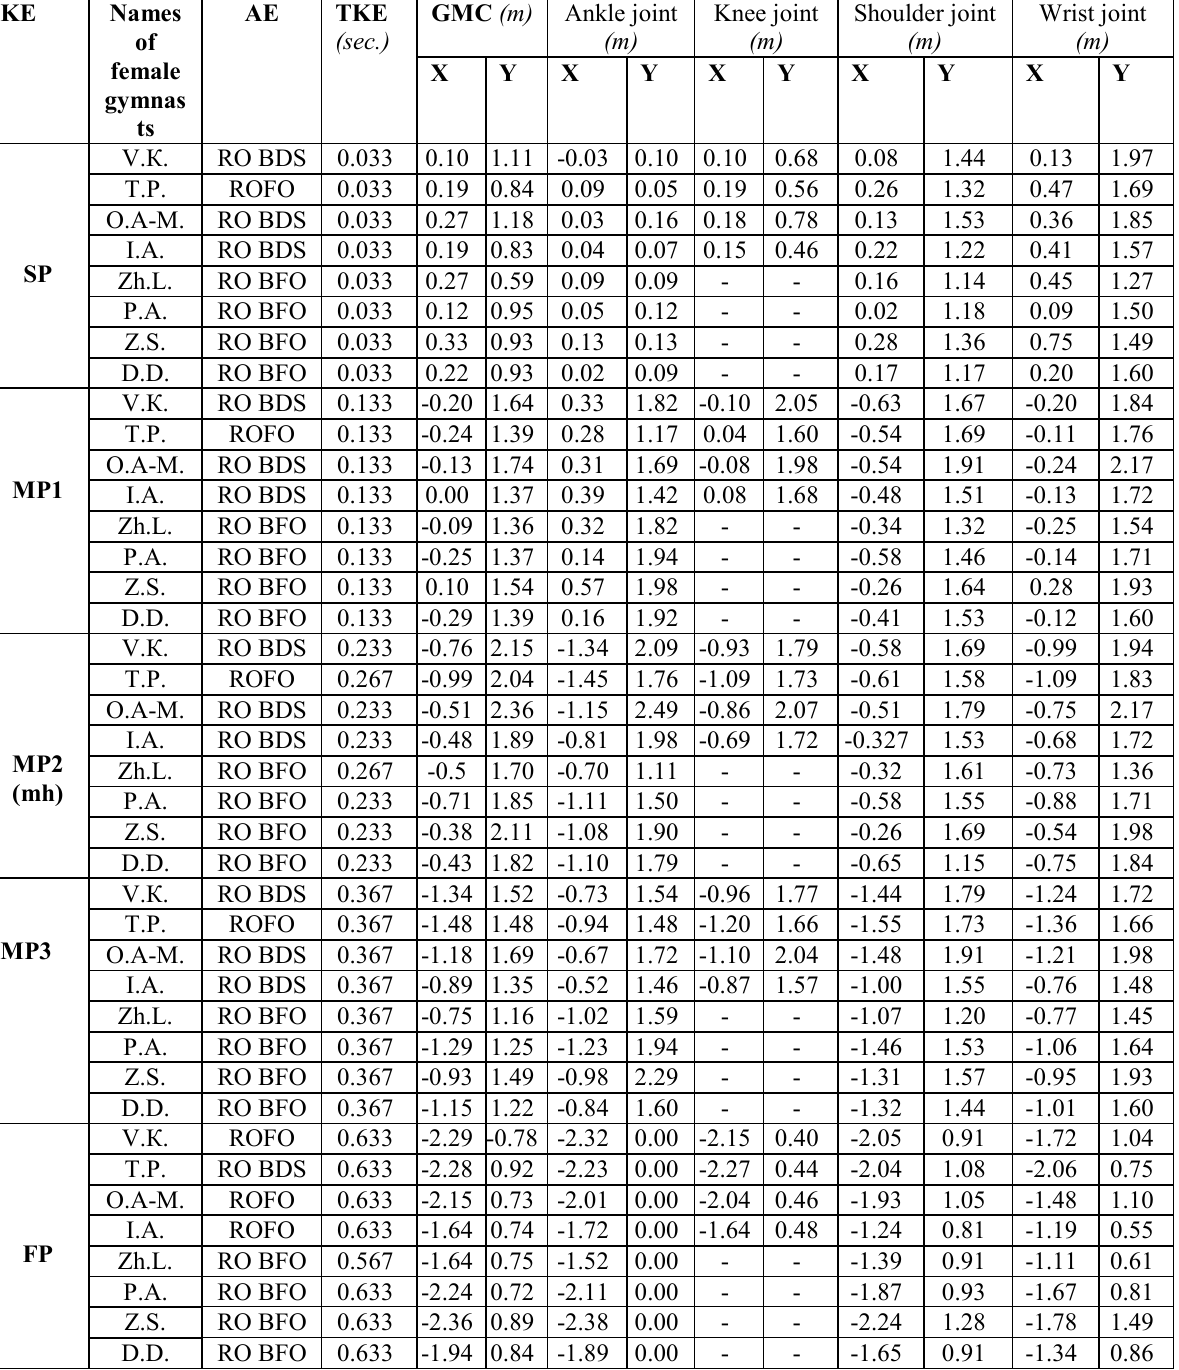
Space-time indicators of joints’ movements in key elements of DTS and DSB jumps’ techniques, fulfilled in FX routine by female gymnasts of 12-14 years old age (n =